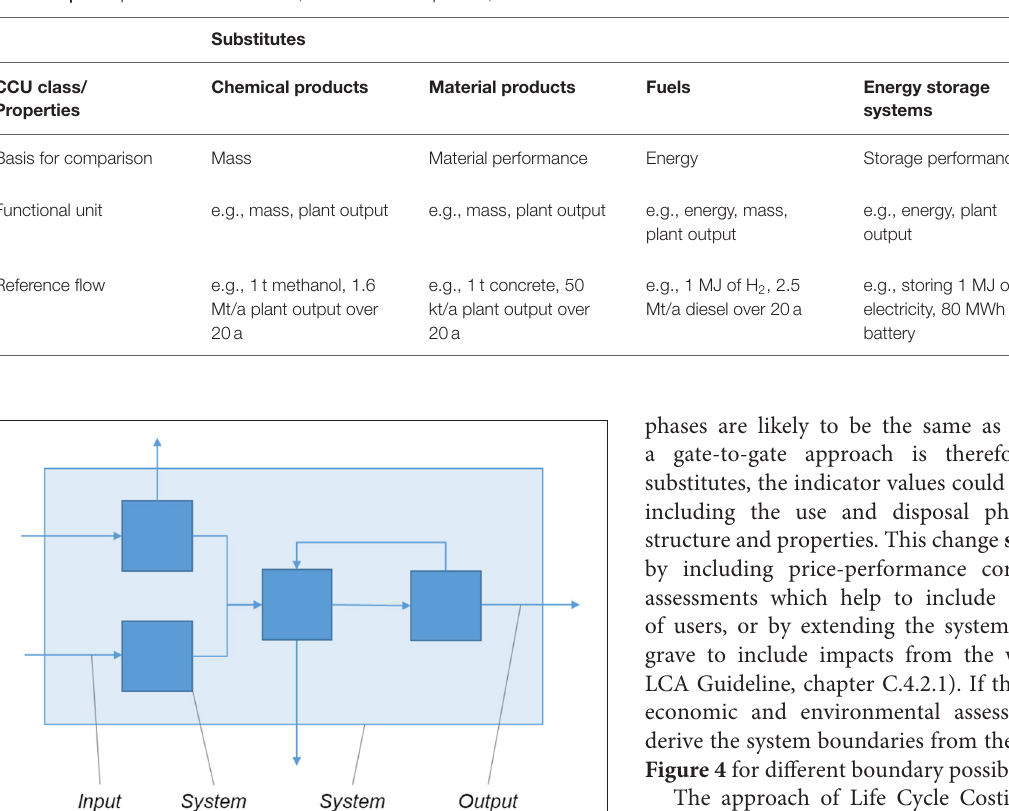
meaning that each system element should serve as the accounting unit for inventory, calculation, interpretation, and